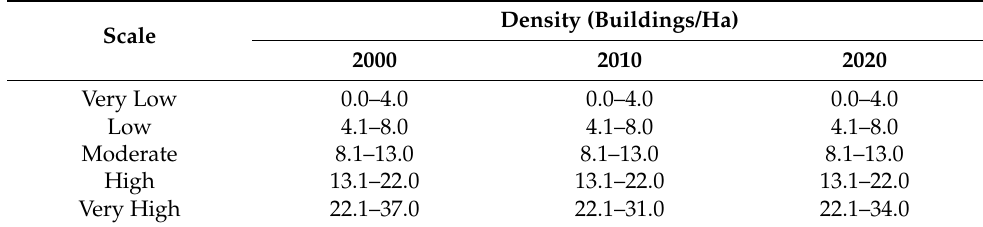
Table 6. The range of built-up density in Batticaloa